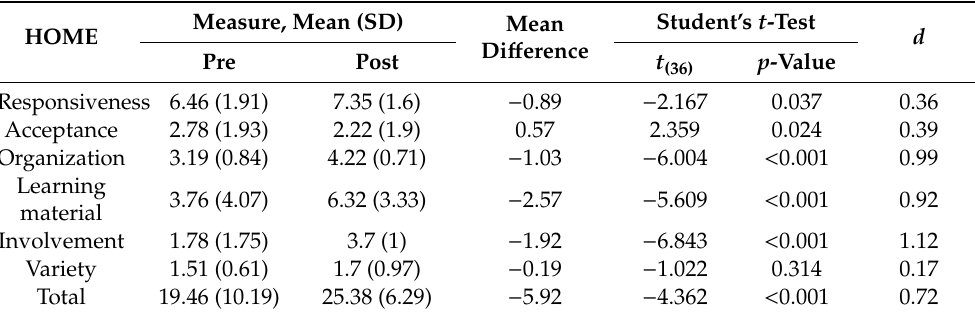
Table 2. Pre and post-intervention